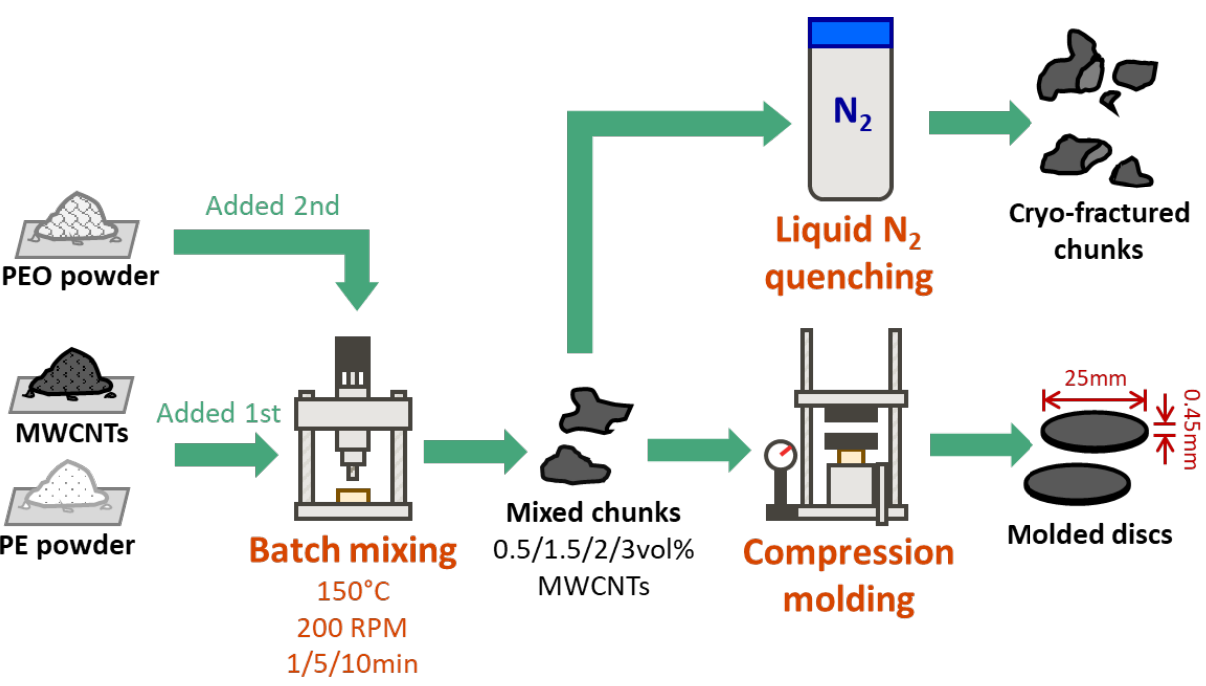
Figure 1. Schematic representation of procedure used to prepare the PEO/PE/MWCNT nanocom- posite samples studied in this work.